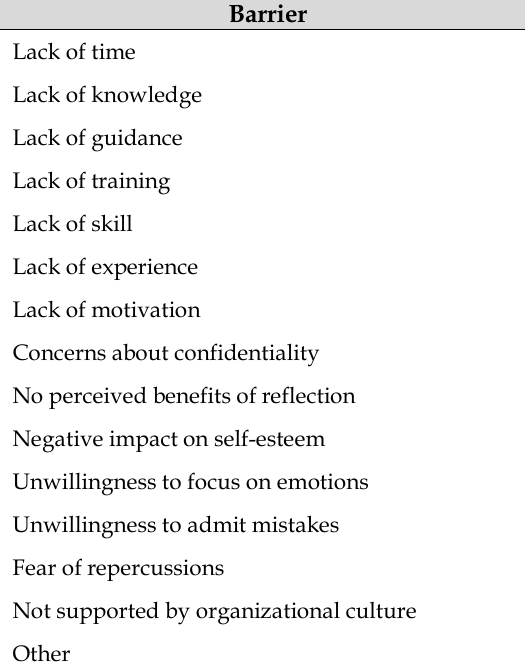
Table 2 Perceived barriers to reflective practice and writing